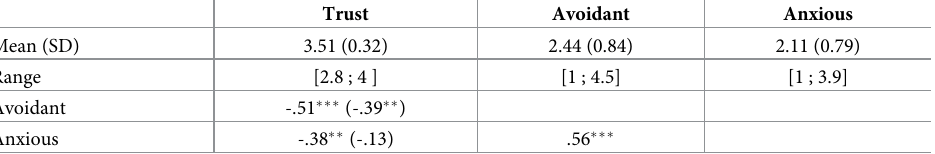
Trust Avoidant Anxious